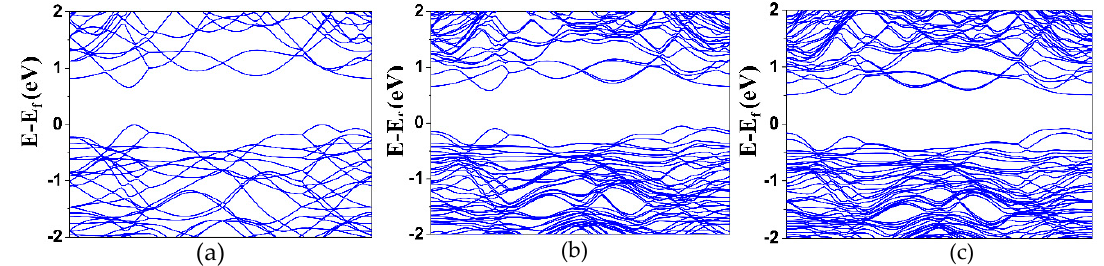
Figure 6. Electronic band structures of the polycrystalline ( a ) SnSe, ( b ) SnSe 0.725 Te 0.125 , and ( c ) SnSe 0.75 Te 0.25 , respectively.